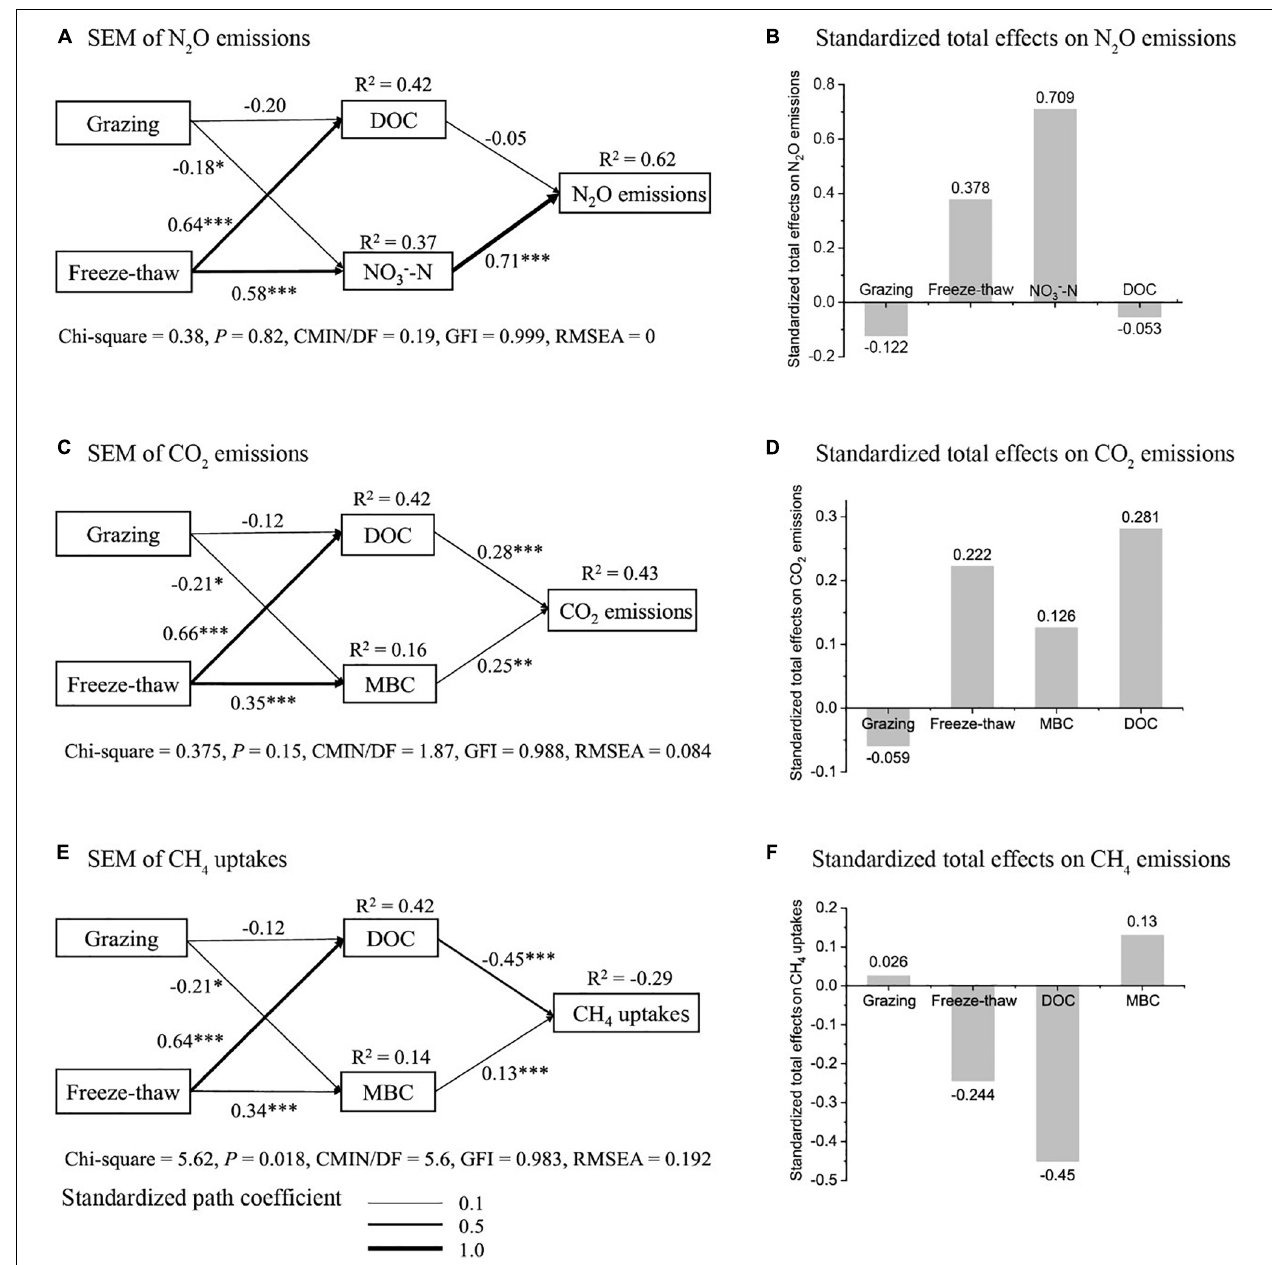
FIGURE 5 | Structural equation modeling (SEM) showing the effects of the combination of grazing and FTCs on soil chemical properties and GHG fluxes (sample size = 126). (A) SEM of N 2 O emissions, (B) standardized total effects on N 2 O emissions, (C) SEM of CO 2 emissions, (D) standardized total effects on CO 2 emissions, (E) SEM of CH 4 uptake, (F) standardized total effects on CH 4 uptake. The numbers on the arrows are the standardized path coefficients; a positive value represents a positive influence, and a negative value represents a negative influence. The “*” next to the path coefficient indicates the significant level of the path coefficient, * P < 0.05; ** P < 0.01, *** P < 0.001. R 2 indicates the explanation degree of response